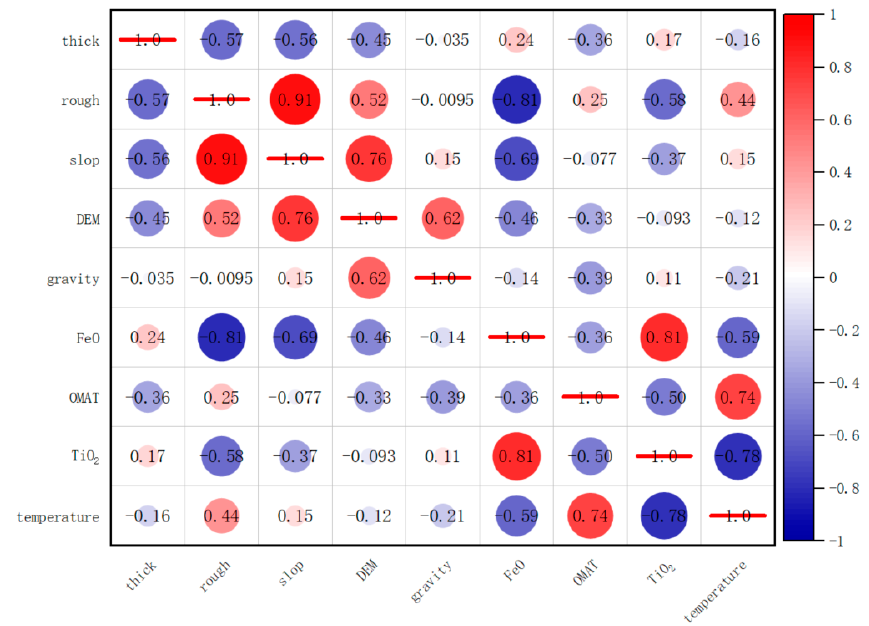
Figure 2. Using nine pieces of candidate evidence data of lunar crust thickness, roughness, slope, digital elevation model, gravity gradient, iron oxide content distribution, lunar soil optical maturity, titanium dioxide, temperature, and rock abundance, we calculated correlation coefficient for the whole moon.